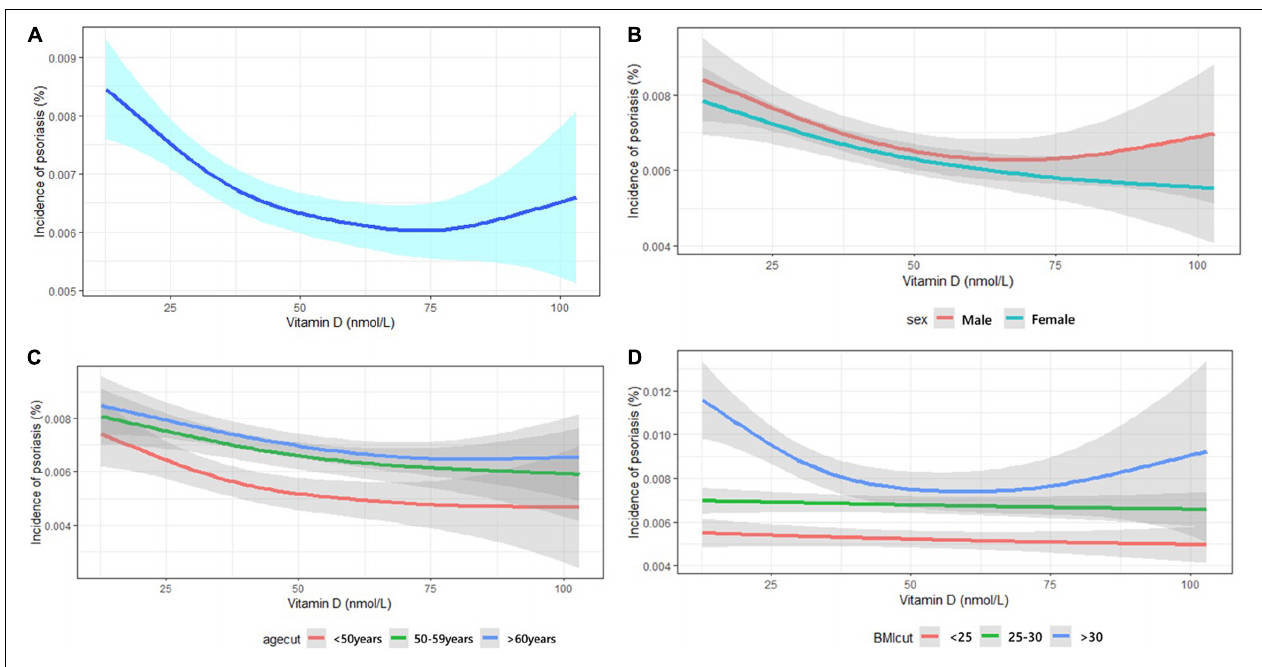
FIGURE 1 | Dose-effect relationship between vitamin D and